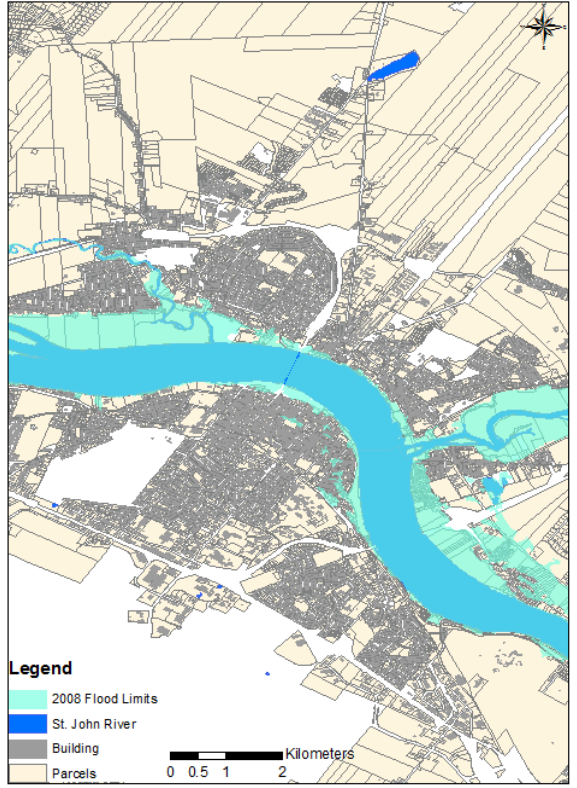
Figure 2, The City of Fredericton, with St. John River splitting the city and digitized flood boundary from 2008 flood